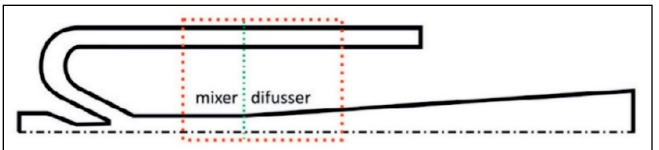
Figure 4 . Ejector with a bypass [44]. Figure 4. Ejector with a bypass